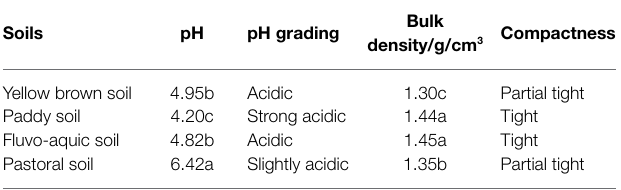
TABLE 1 | Soil acidity and bulk density